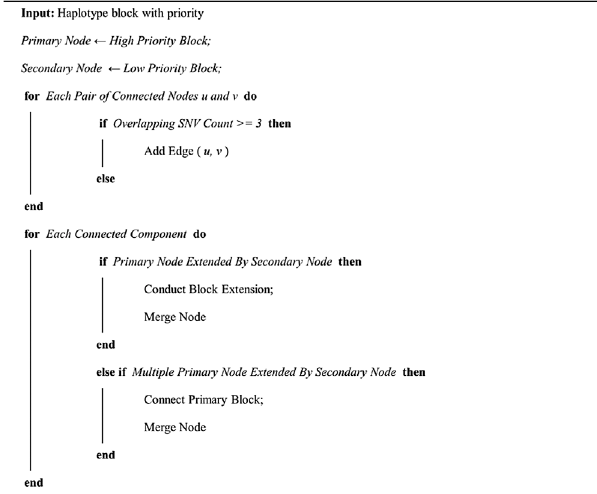
Algorithm 1: Haplotype merging